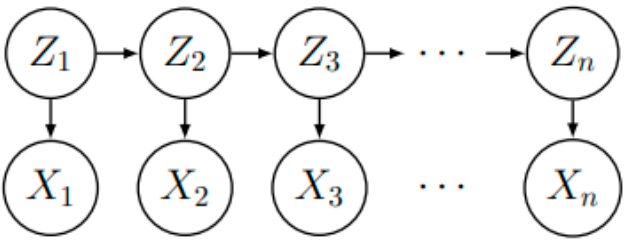
Figure 3. A discrete hidden Markov